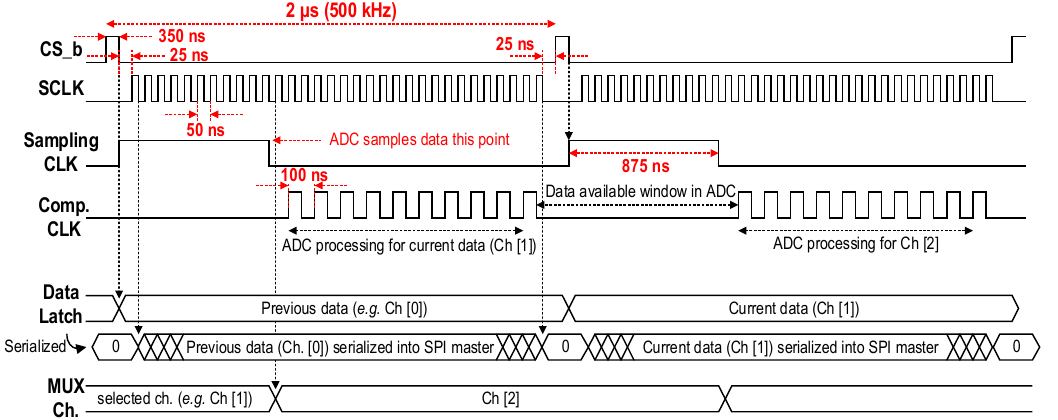
Figure 10. Timing diagram for serial peripheral interface (SPI) operation.